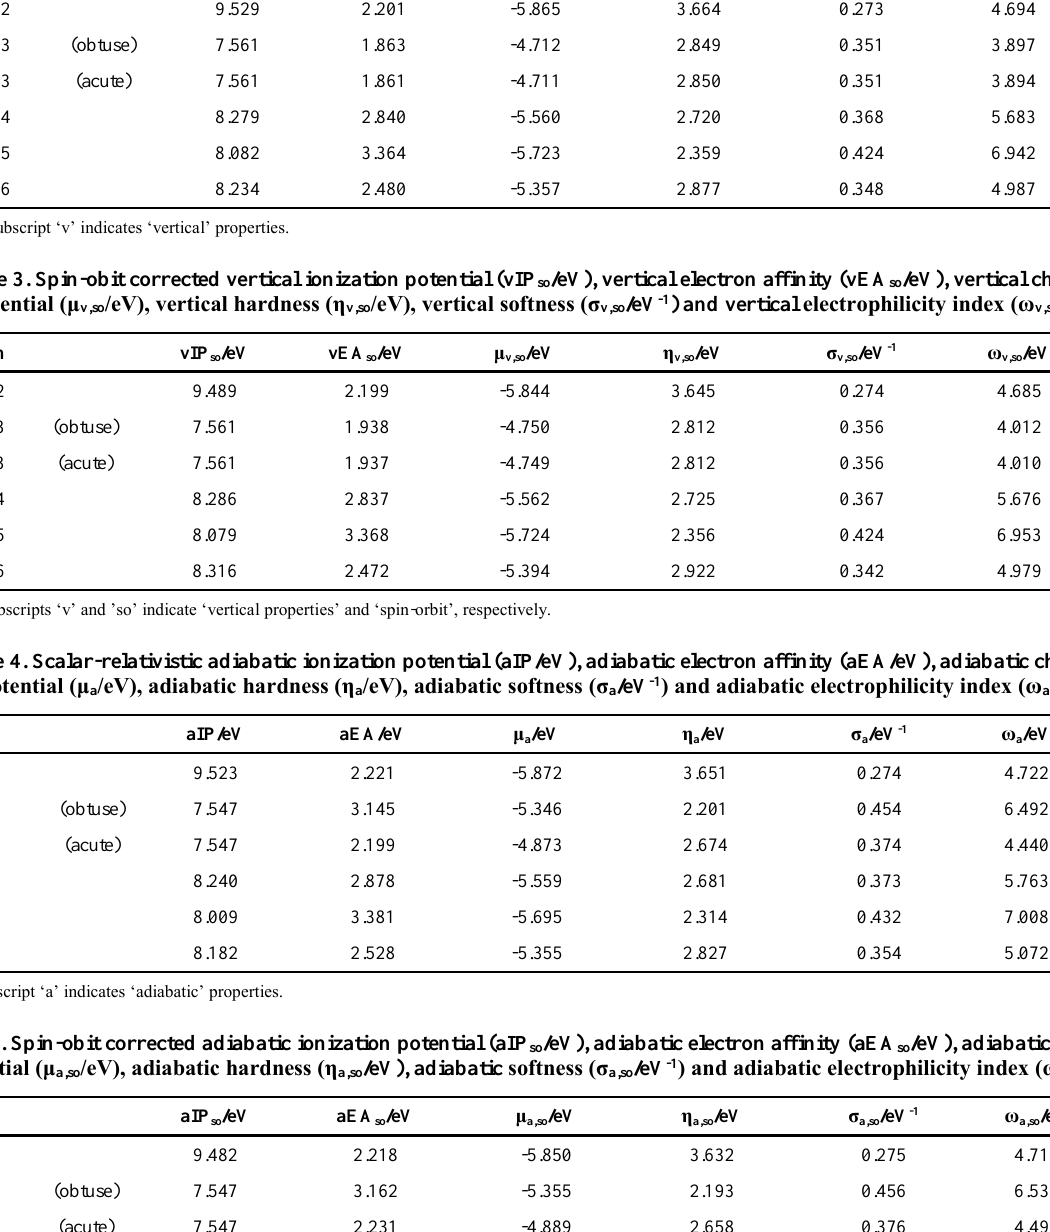
Table 2. Scalar-relativistic vertical ionization potential (vIP/eV), vertical electron affinity (vEA/eV), vertical chemical potential (μ v /eV), vertical hardness (η v /eV), vertical softness (σ v /eV -1 ) and vertical electrophilicity index (ω v /eV) n